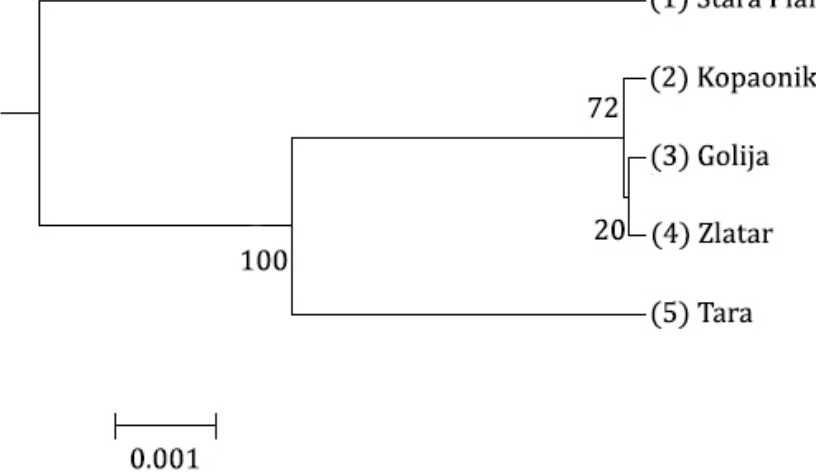
Figure 3. UPGMA tree using Nei’s [37] genetic distance. Population number is given inside brackets. Bootstrap values are presented at the branch intersections.